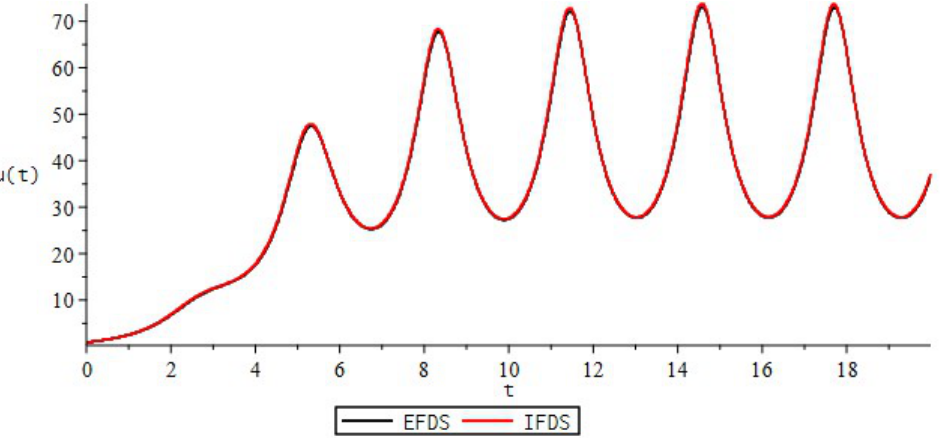
Figure 5. Numerical solutions of the fractional Riccati equation with variable coefficients α ( t ) = 0.9 − 0.1 t / T —monotonically decreasing function